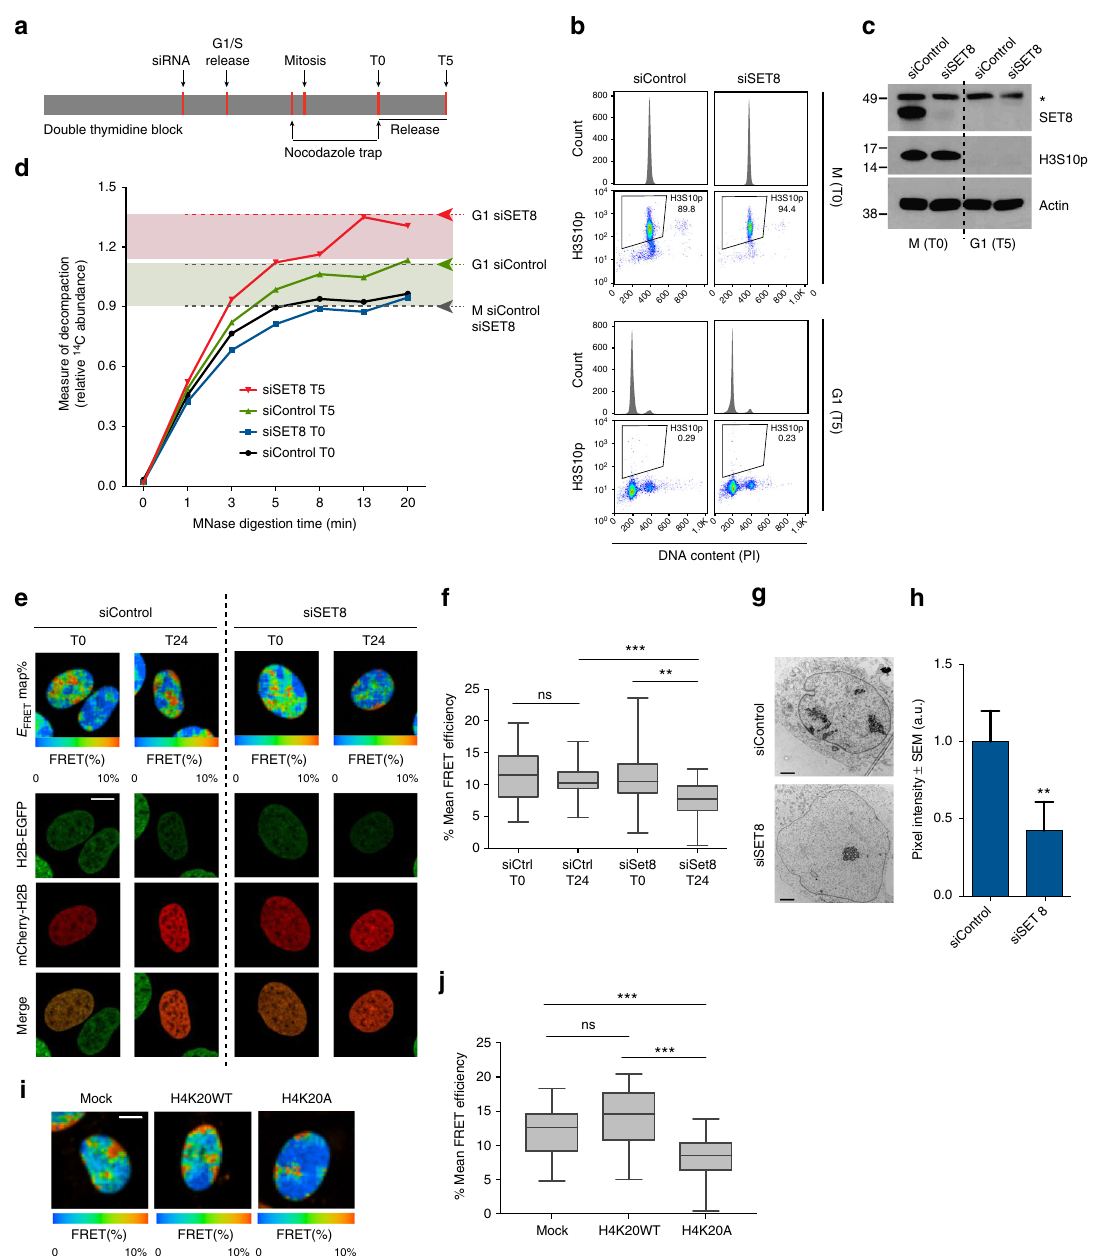
Fig. 1 SET8 and H4K20 methylation regulate ground-state chromatin compaction in cells exiting mitosis. a U2OS cells were synchronized with double thymidine block. Control and SET8 siRNAs transfected 6 h before G1/S release. Cells were then blocked in mitosis with nocodazole for 4 h (T0) and released into G1 phase for 5 h (T5). MNase digestion was performed on mitotic arrested and G1 phase cells. Thymidine containing methyl- 14 C was added throughout the experiment. b Cells from a were fi xed and stained with phospho-Histone H3S10 antibody and propidium iodide (PI) followed by fl ow cytometric analysis. c Immunoblots of total cell lysates prepared from the samples in a probed with the indicated antibodies. Asterisk (*) represents a non- speci fi c band. d Graph showing MNase digestion pro fi le. Levels of methyl- 14 C in the supernatant indicates the degree of chromatin decompaction over time when incubated with MNase. e U2OS cells stably expressing H2B-GFP alone (U2OS H2B-GFP ) or with mCherry-tagged histone H2B (U2OS H2B-2FPs ) were synchronized with single thymidine block. Cells were treated with either control or SET8 siRNA during the block. FRET measurements were taken before (T0) and 24 h after release (Bar, 10 µ m). f Quanti fi cation of the FLIM-FRET chromatin compaction assay. Inside box plots, the thick line represents median, the boxes correspond to the mean FRET values upper or lower of the median, with whiskers extending to the highest and lowest value. n > 30 nuclei, *** p < 0.001, ** p < 0.01 (ANOVA), ns not signi fi cant. g U2OS cells were synchronized and siRNA transfected as in a . Cells were fi xed at 15 h post release for transmission electron microscope (TEM) visualization. h Quanti fi cation of the average pixel intensity ± SD ( n > 15) of nuclei in g . ** p < 0.01 (unpaired t test). i U2OS cells stably expressing H2B-GFP alone (U2OS H2B-GFP ) or with mCherry-H2B (U2OS H2B-2FPs ) were transduced with FLAG-tagged Histone H4WT or H4K20A mutant. Mock transduced cells were taken as control. FRET measurements were taken for all the samples (Bar, 10 µ m). j Quanti fi cation of the mean FRET levels in Mock, H4K20WT-, and H4K20A-expressing cells. Box plots represents mean FRET values as de fi ned earlier ( f ). n > 30 nuclei. ns not signi fi cant, *** p < 0.001